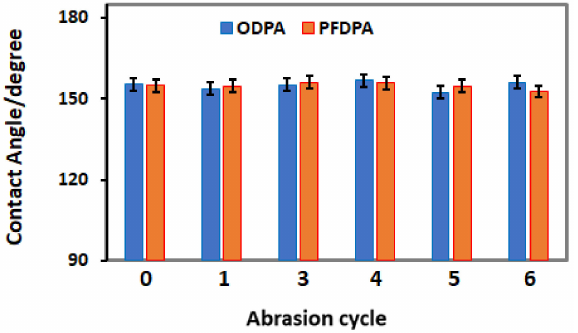
Figure 7. CA versus number of abrasion cycles: ODPA@TNTA (blue bar) and PFDPA@TNTA (orange bar) samples. An abrasion cycle consists of pushing the sample with 50 g weight on it through a 320-grit sand paper for a distance of 5 cm. The CA was measured at the end of each